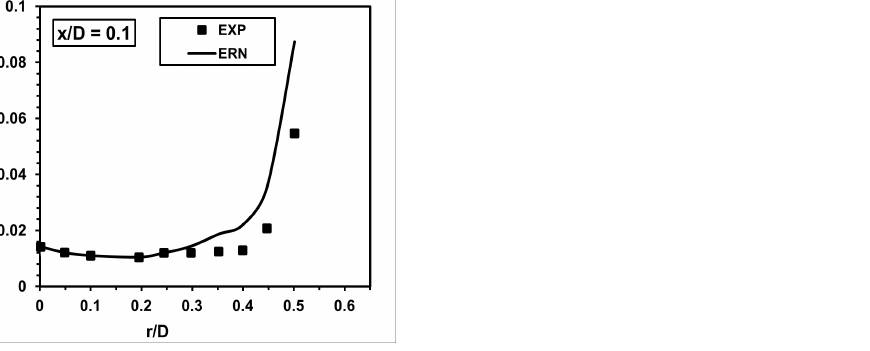
Figure 11. The computed mean CO mole fraction is compared to the experimental measurements at axial locations x / D =